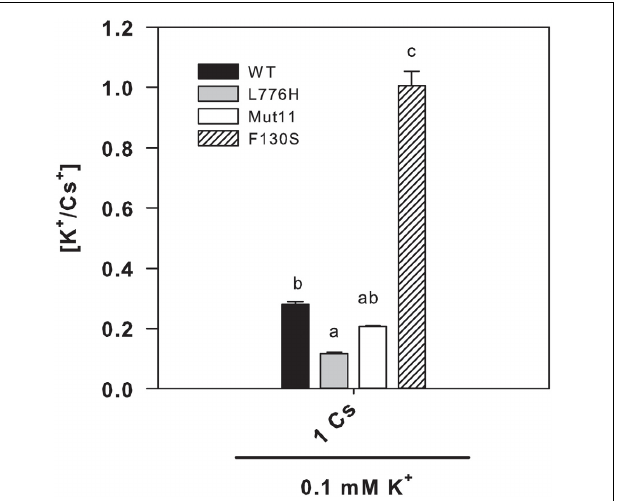
FIGURE 5 | Internal K + /Cs + ratios of 9.3 yeast cells expressing WT AtHAK5 and mutated AtHAK5 K + transporters. Cells were treated and analyzed as indicated in Figure 4 . Shown are the ratios of internal K + /Cs + concentrations of the cells grown in the presence of 0.1mM K + and 1mM Cs + . Reported values are the average of at least 6 replicates and error bars denote standard error. Columns with different letters within each ionic treatment are significantly different according to Tukey test ( p < 0 .